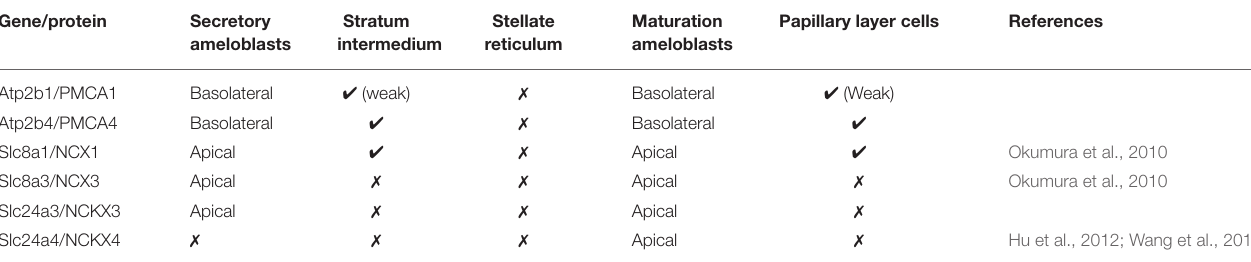
TABLE 3 | Major and most highly expressed calcium export pumps and exchangers in enamel organ cells. Gene/protein Secretory